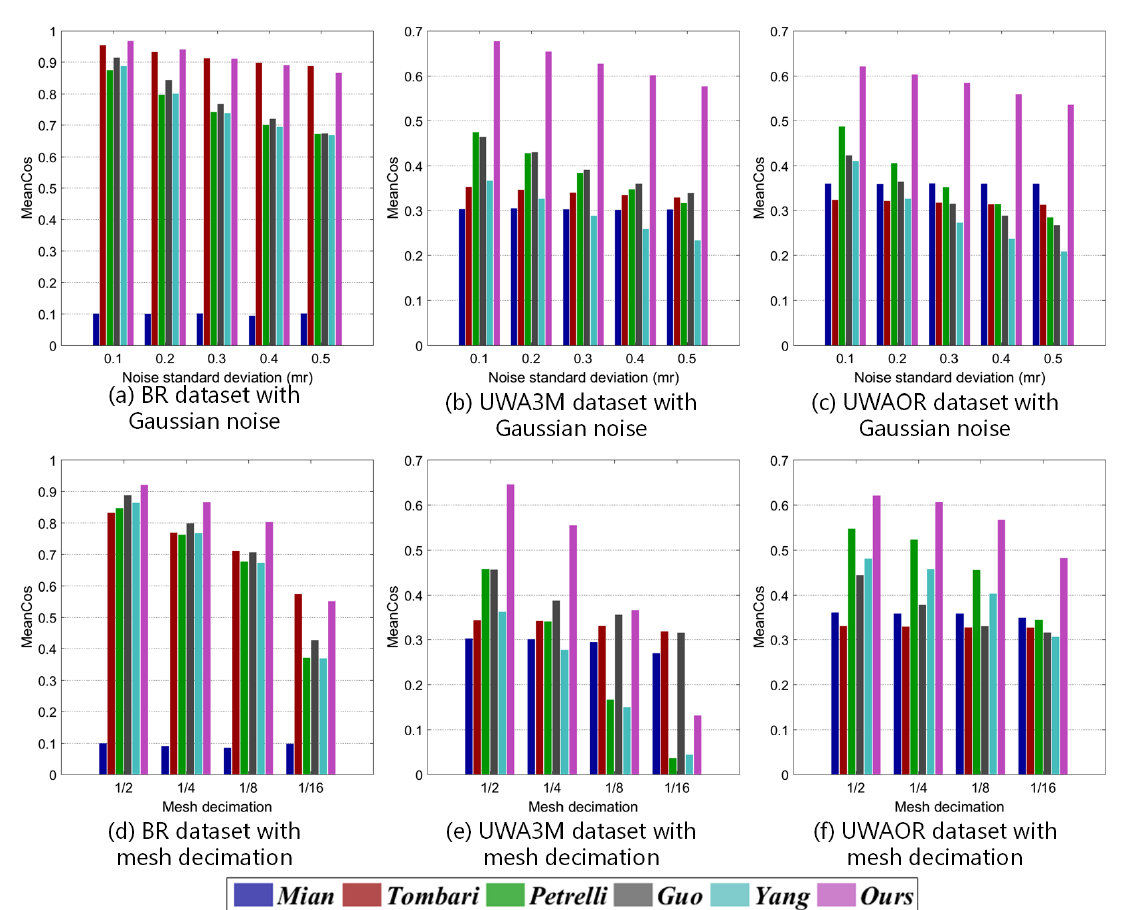
Figure 7. Robustness performance of six LRF methods on the BR, UWA3M, and UWAOR datasets with Gaussian noise and mesh